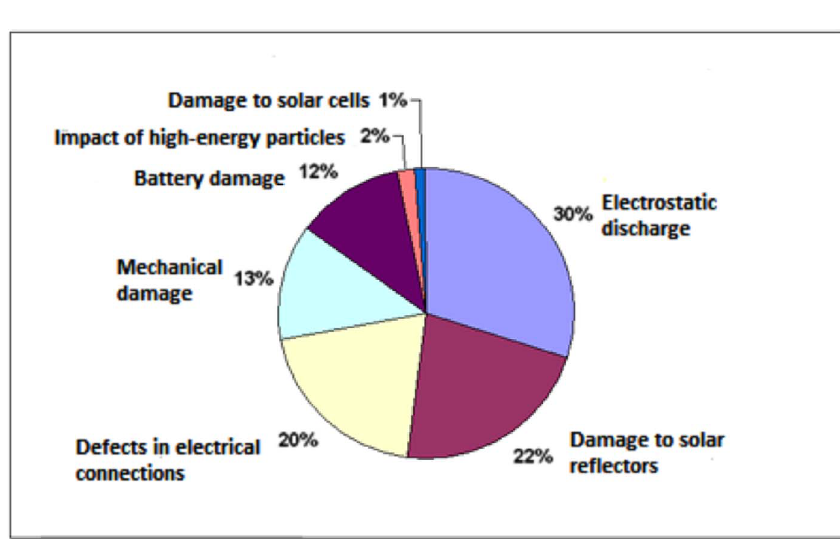
Figure 1. Types of spacecraft damage in geostationary